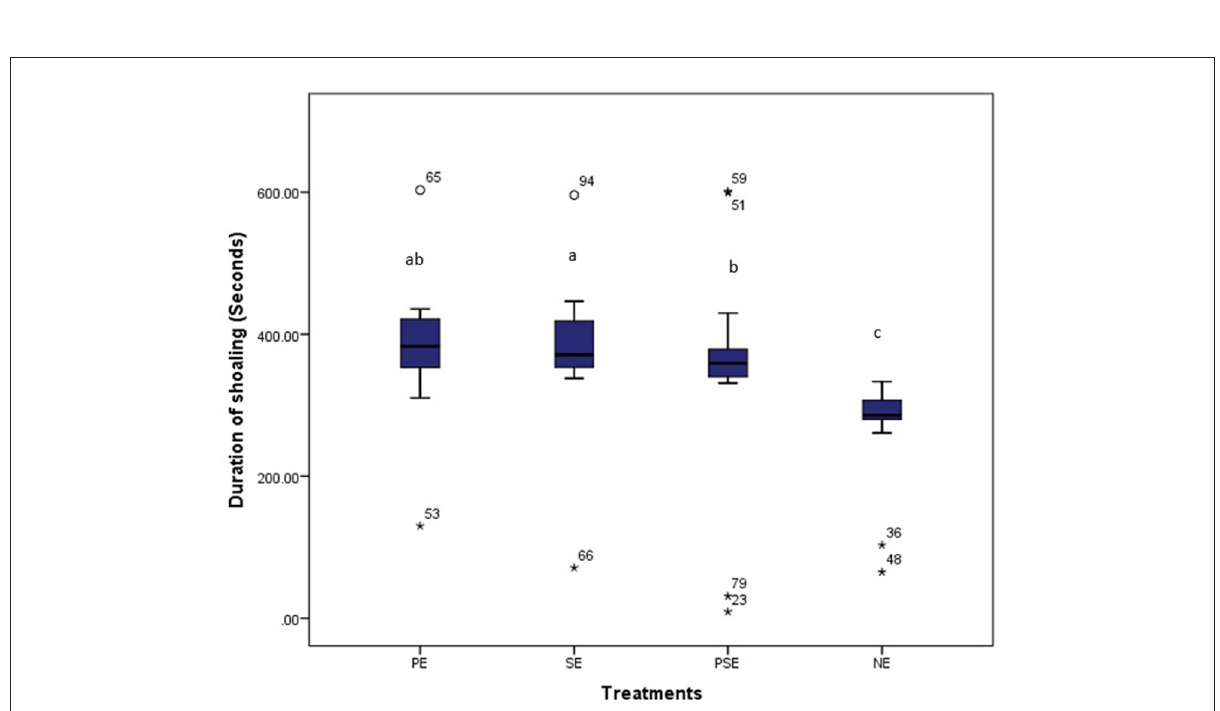
FIGURE6 Average time (secs) spent by juveniles of C. gariepinus in displaying shoaling behaviour at plant enriched (PE), substrates enriched (SE), plant and substrates enriched (PSE) and non-enriched (NE) culture tanks. abcd Mean values with different superscripts were significantly ( p < 0.05) different between